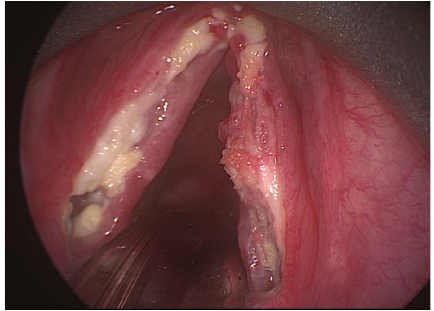
Figure 1: Invasive aspergillosis of the larynx.